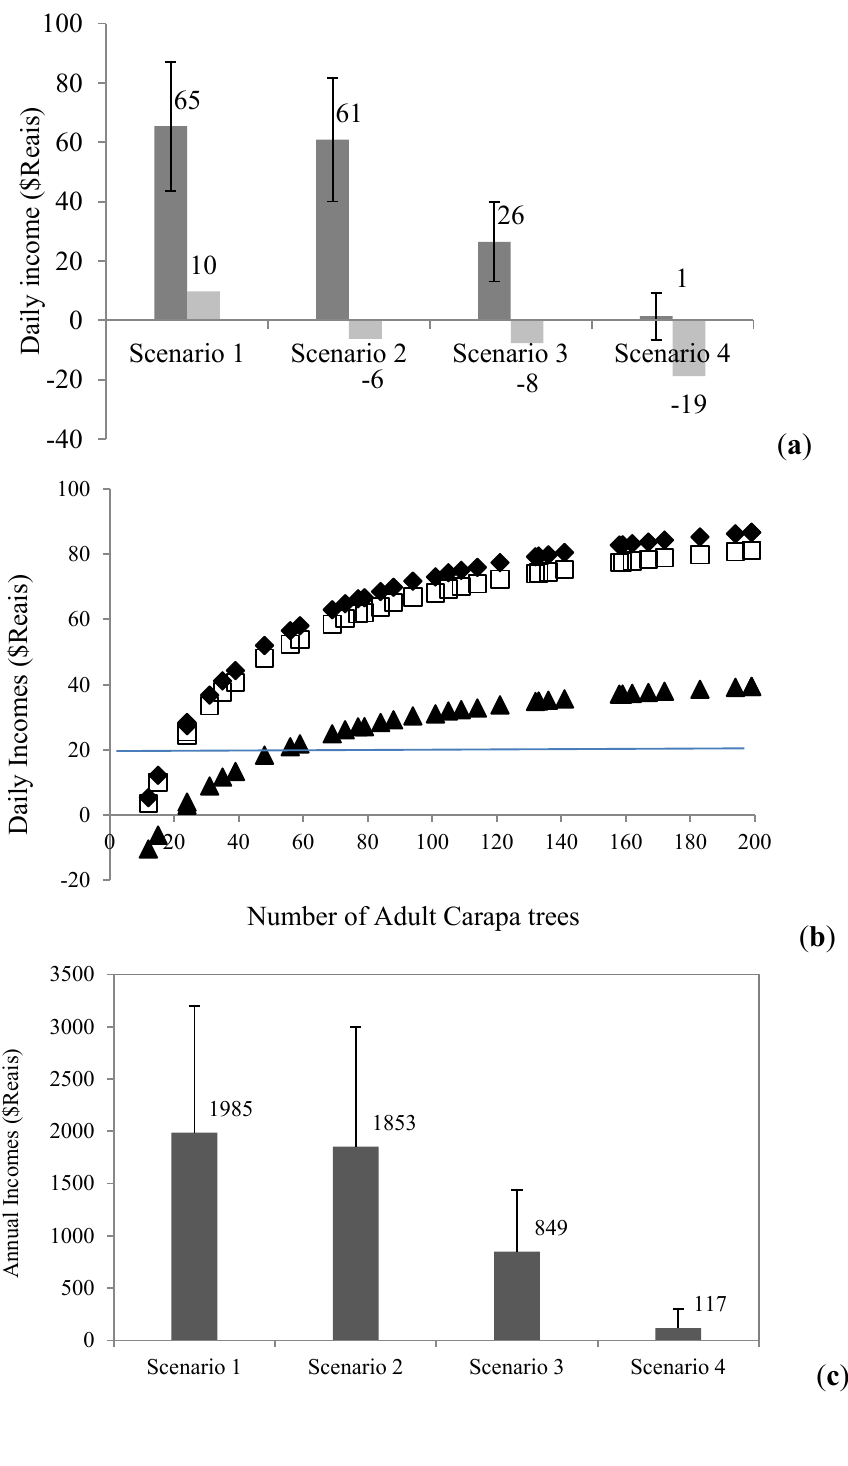
Figure 5. Incomes from andiroba oil production; ( a ) Daily incomes of the four scenarios in low fruit production period and during high fruit production; ( b ) relation between number of adult tree in the permanent forest reserve in each farm and daily incomes generated; ( c ) annual incomes in the four scenarios during a masting fruit